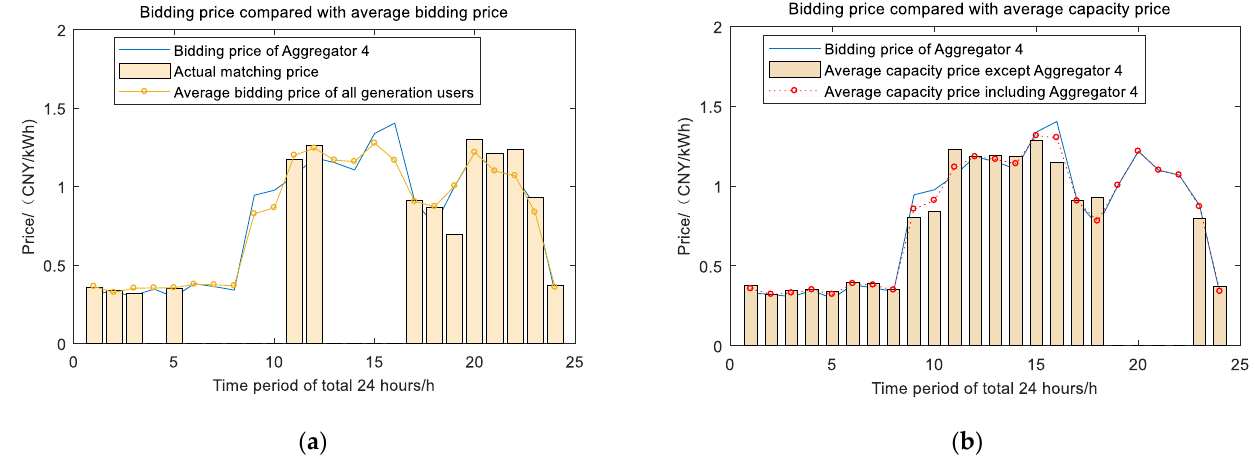
Figure 18. The bidding price comparison. ( a ) Compared with average bidding price; ( b ) Compared with average capacity price.